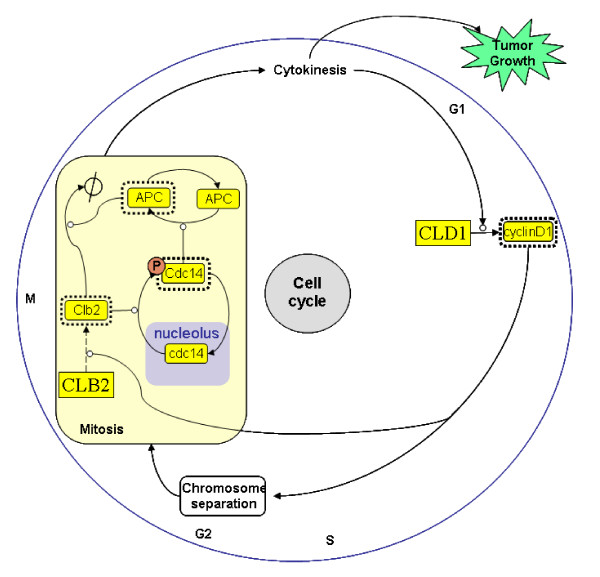
The cell cycle model shown integrates chemical kinetics, enzyme catalyzed reactions and discrete events, such as chromosome separation, cell division, and entry/exit to a combined G1SG2 phase. Tumor growth is a process that is linked explicitly to the cell cycle, thus providing a quantitative model that connects a molecular process model to a clinical manifestation. Each cell division increments tumor size, while a continuous apoptotic reaction causes slow decay of tumor size. Rules for this cell cycle model are given in the text. Simulation results are presented in the succeeding figures.